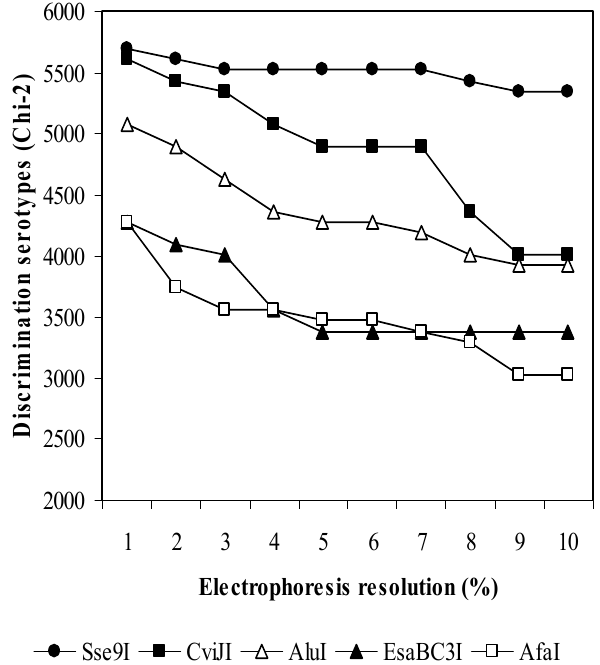
Figure 1. Discrimination values between serotypes by analysis of fragments produced by digestions with different restriction enzymes in the region wzg–wzh–wzd–wze . The values are given as a function of the resolution of the electrophoresis system. All the fragments of 100 bp and over are considered for the analysis.